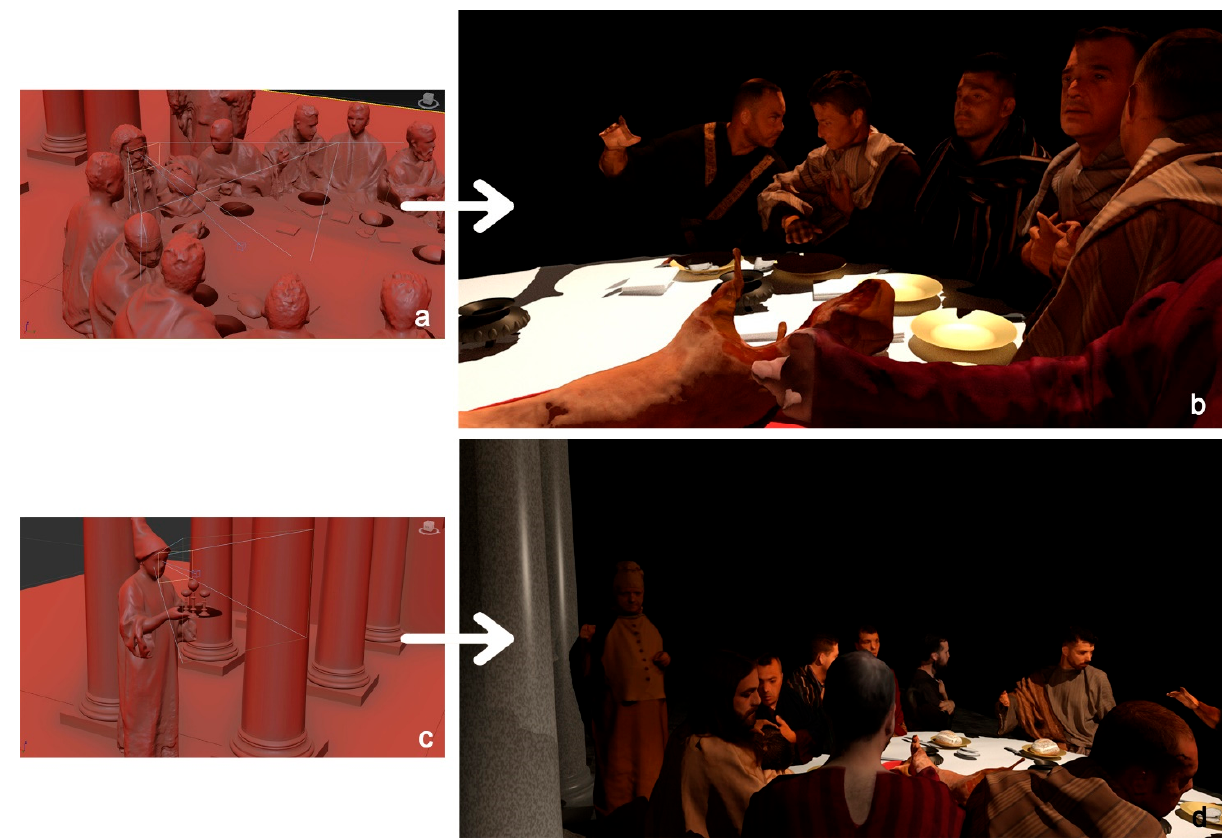
Figure 20. ( a , b ) Virtual camera positioned on Jesus and relative view; ( c , d ) virtual room positioned on the servant and relative view.